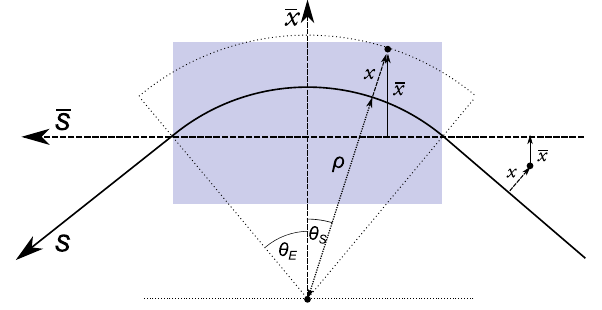
FIG. 1. Rectangular dipole and two coordinate systems.